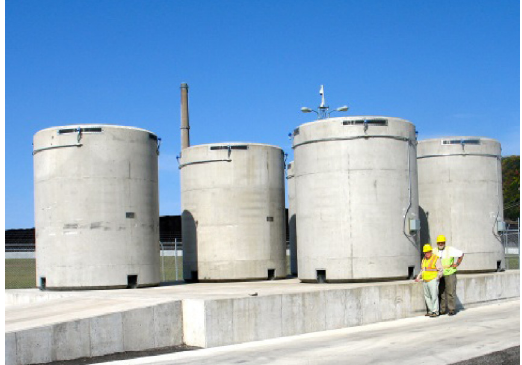
Fig. 4. Vertical concrete casks (Courtesy of NAC International).